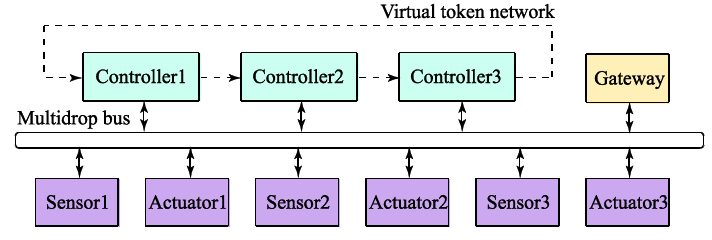
Figure 5. Typical wired configuration [15].